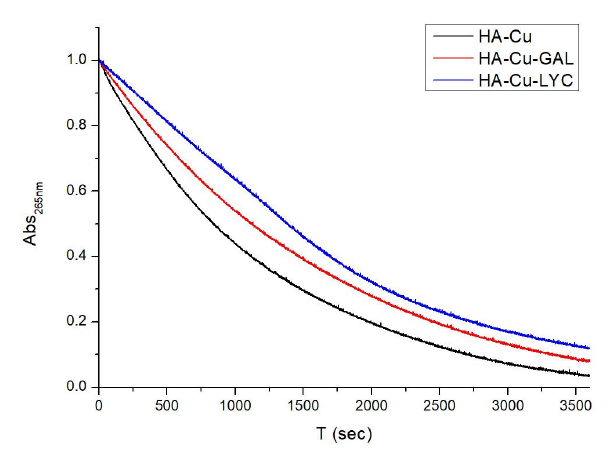
Figure 6. UV ‐ Vis kinetic curve of ascorbate oxidation by Cu(II) ions in absence (black lines) and in presence of equimolar GAL (red lines) and LYC (blue lines) concentrations. Ascorbate concentration 50 μ M, 200:1 ascorbate:copper(II) ratio, phosphate buffer 3 mM solution, pH 7.5, T = 298 K. 2.4. The Protective Role of GAL and LYC Against A β‐ Induced Cytotoxicity